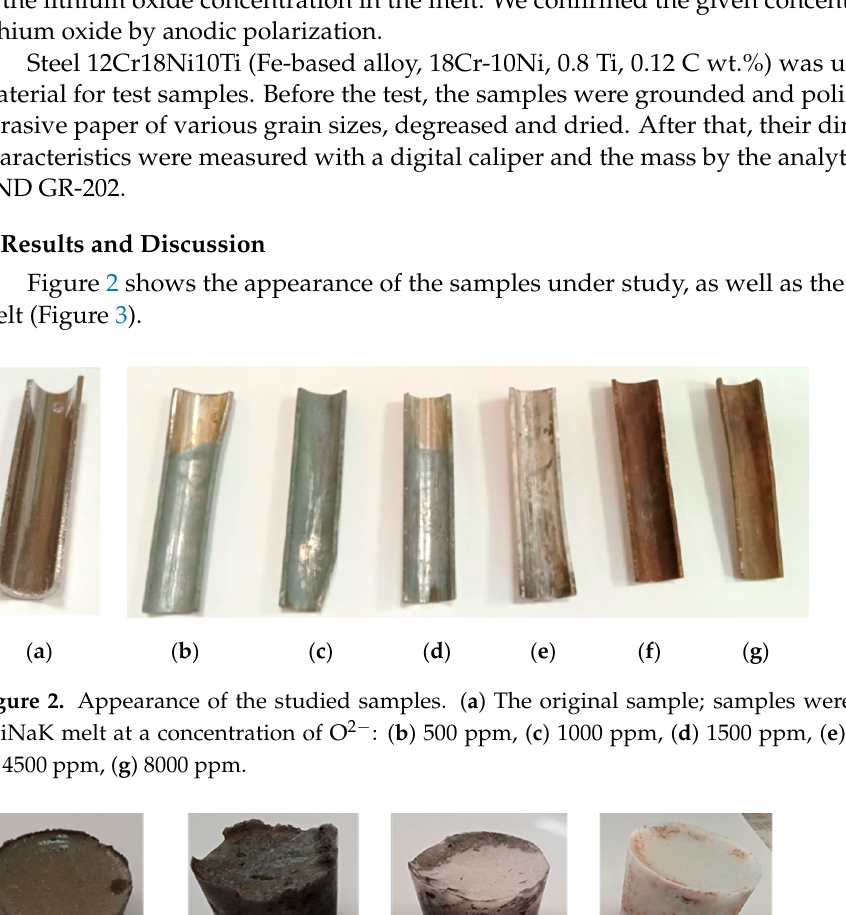
Table 2. Corrosion rate of 12Cr18Ni10Ti steel samples aged in FLiNaK melt at different concentra- tions of Li 2